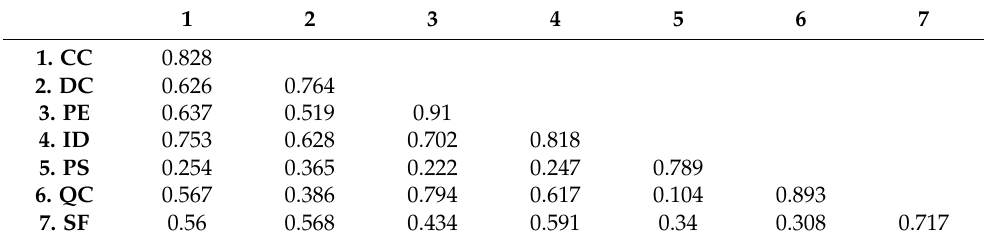
Table 2. Assessment of discriminant validity using the Fornell–Larcker method.